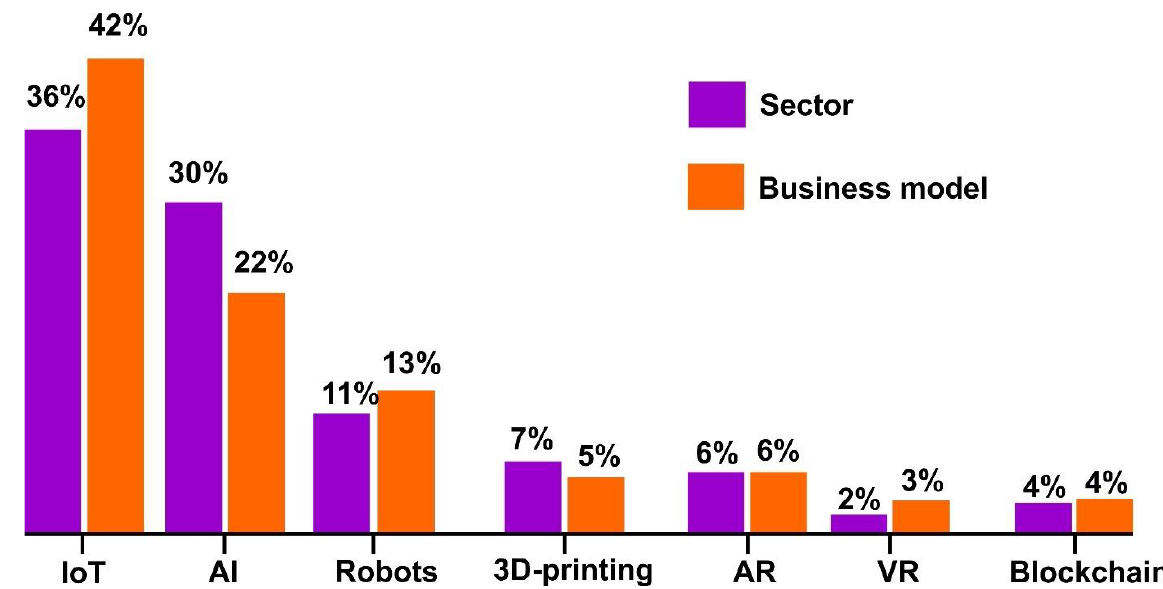
Figure 3. Leading position of IoT in Industry 4.0 structure [80].